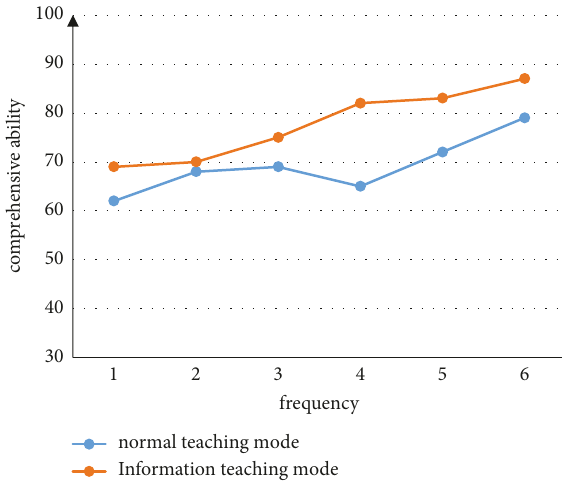
Figure 7: Comparison of different teaching modes in compre- hensive ability Table 1: Comparison of different teaching methods in terms of learning effect.